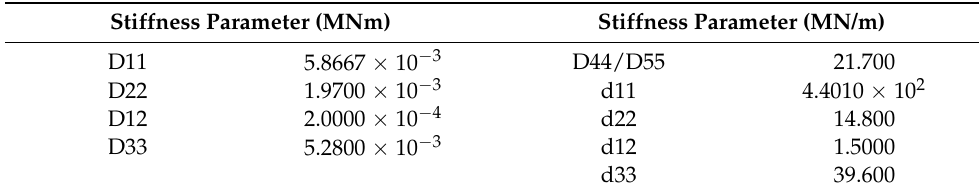
Table 1. Parameters of orthotropy for the outer layers (40 mm) of the CLT 140-3. Stiffness Parameter (MNm) Stiffness Parameter (MN/m)